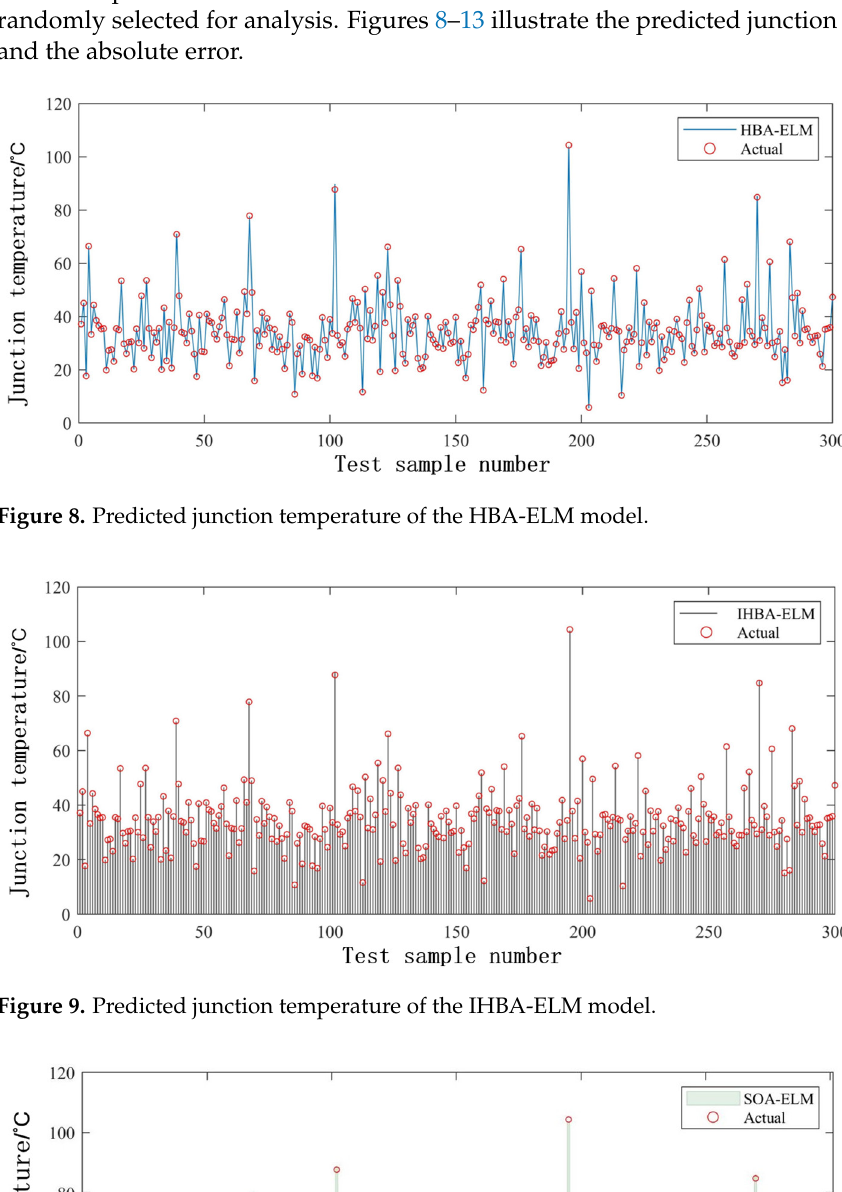
Figure 11. Predicted junction temperature of the ELM model. Figure 12. Predicted junction temperature of the BPNN model.